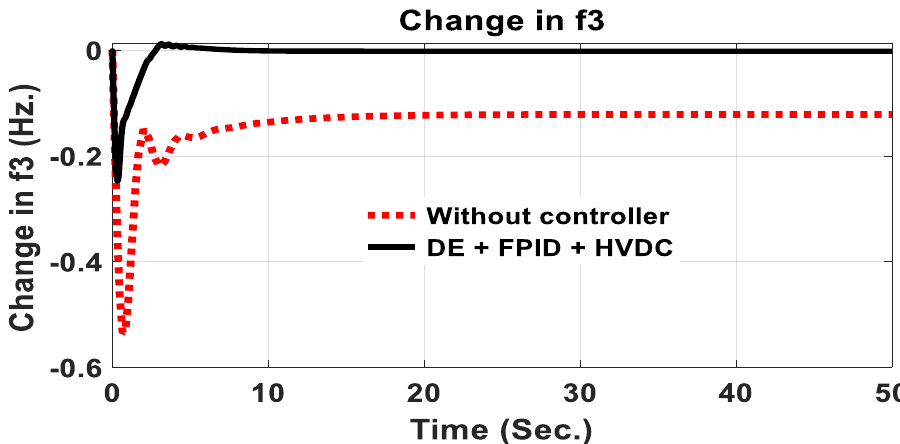
Figure 7. Comparison of controller and without controller for frequency deviation f3.